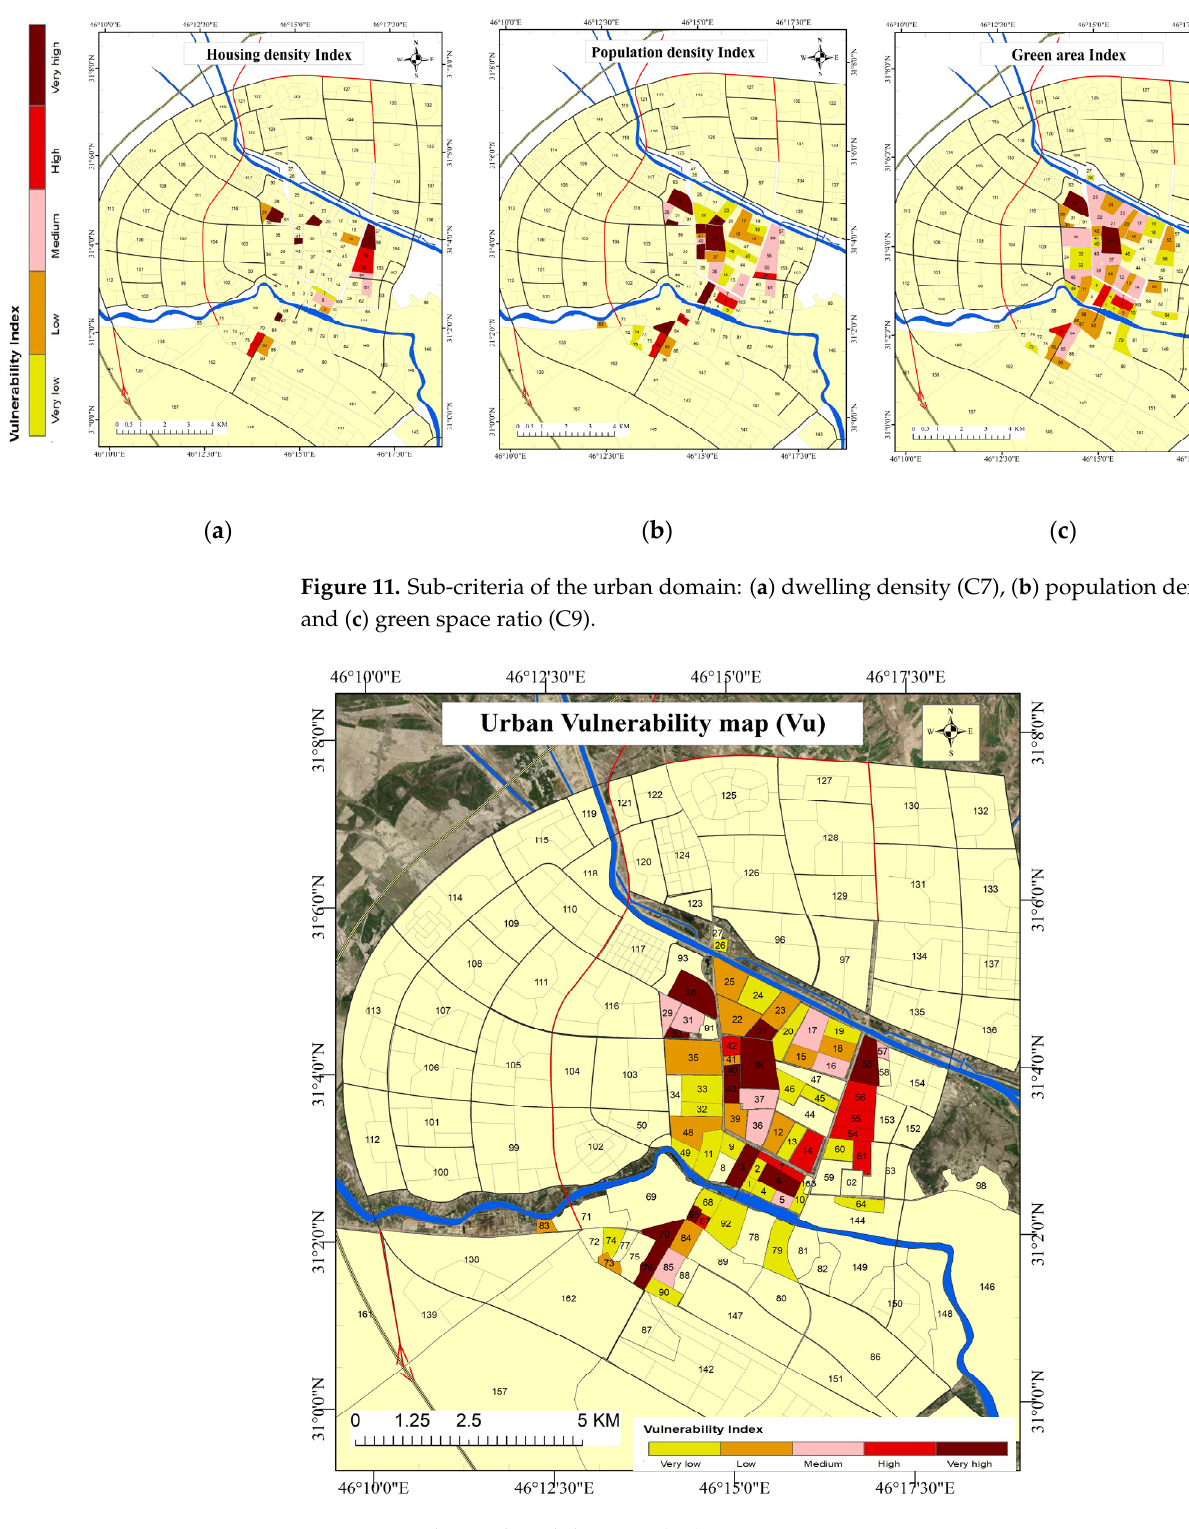
Figure 12. Urban vulnerability map (Vu).